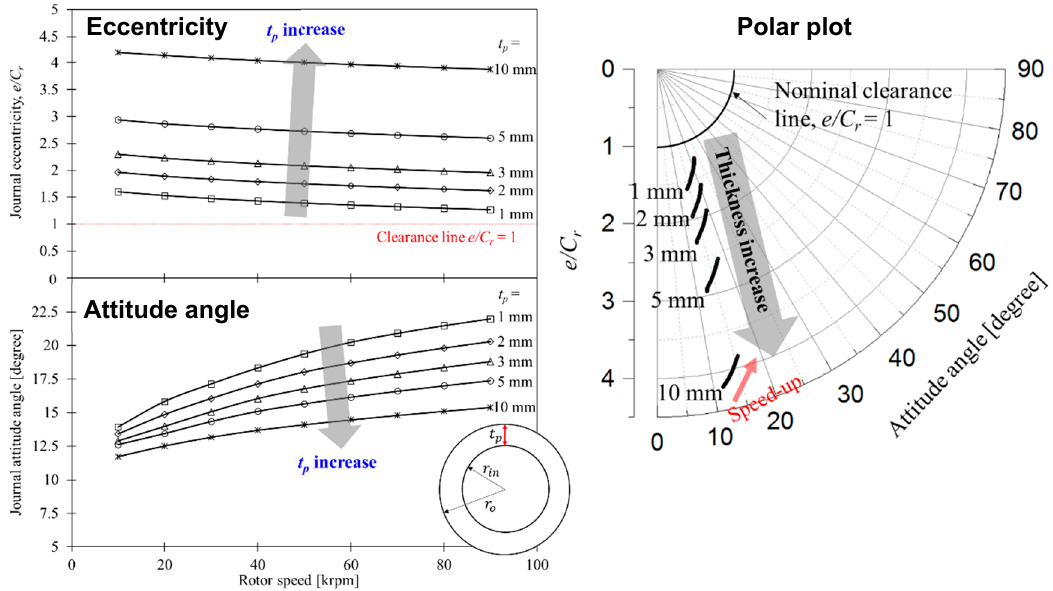
Figure 7. Predicted journal eccentricity and journal attitude angle versus the rotor speed and polar plot of journal equilibriums positions depending on the polymer layer thickness.